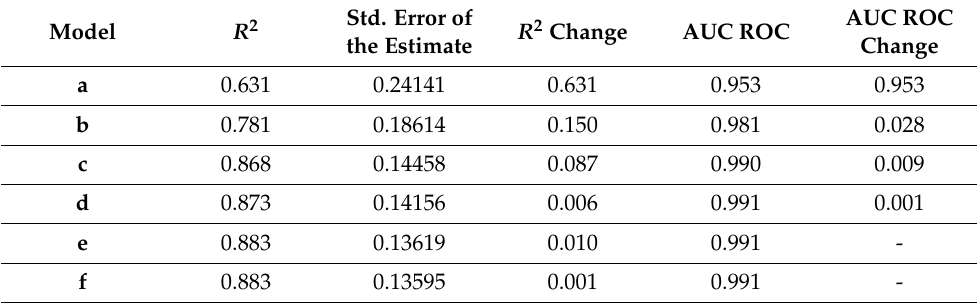
Figure 2. Correlation of model predicted steady-state sorafenib concentration predicted sorafenib AUC. Table 1. Multivariable linear regression model performance characteristics.